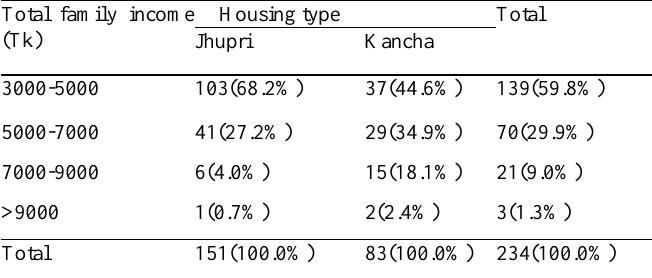
Table-3: Distribution of respondents by family income with housing